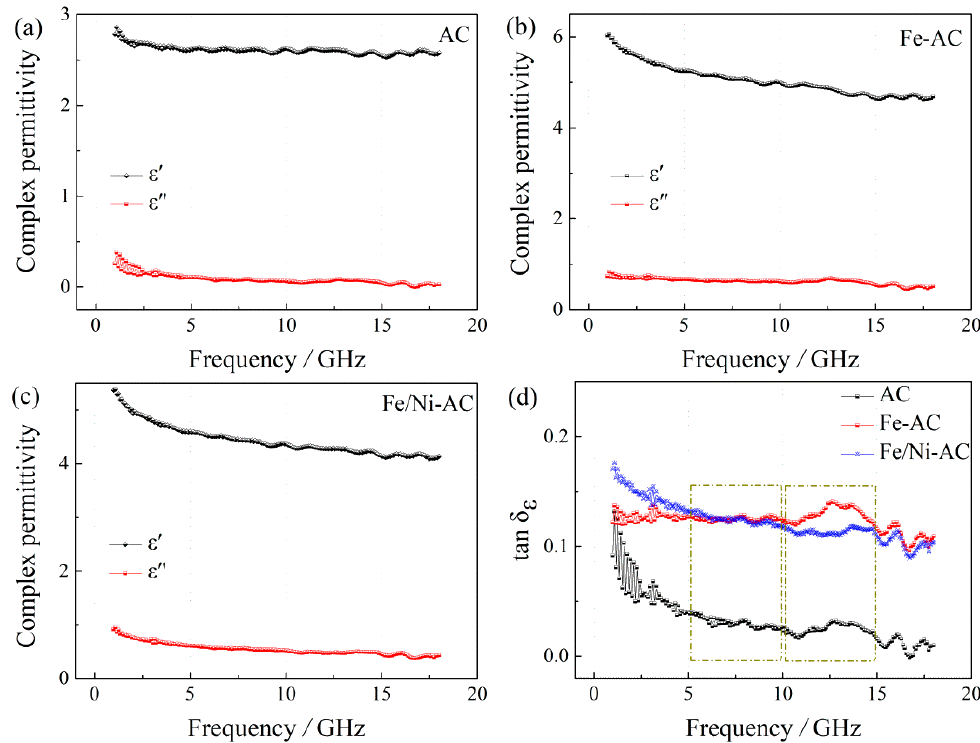
Figure 7. Complex permittivity ( ε r ) of real parts ( ε ′ ) and imaginary parts ( ε ″ ) of: ( a ) AC, ( b ) Fe-AC, and ( c ) Fe/Ni-AC, and ( d ) their tan δ ε = ε ″ / ε ′ .